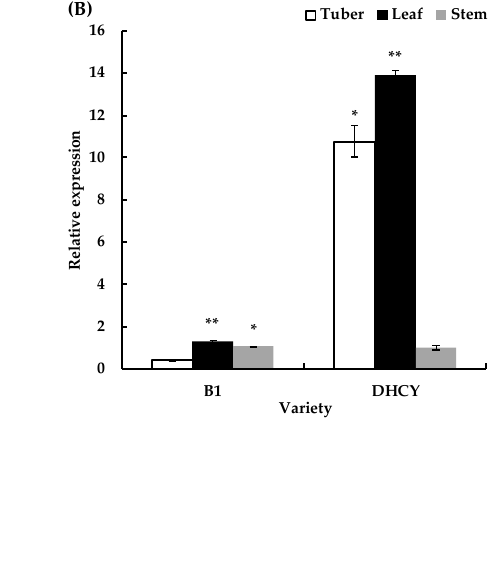
the initial zero-hour time point (Figure 2C). To conclude, the results indicate that DoBAM1 is responsive to cold stress. cold stress.